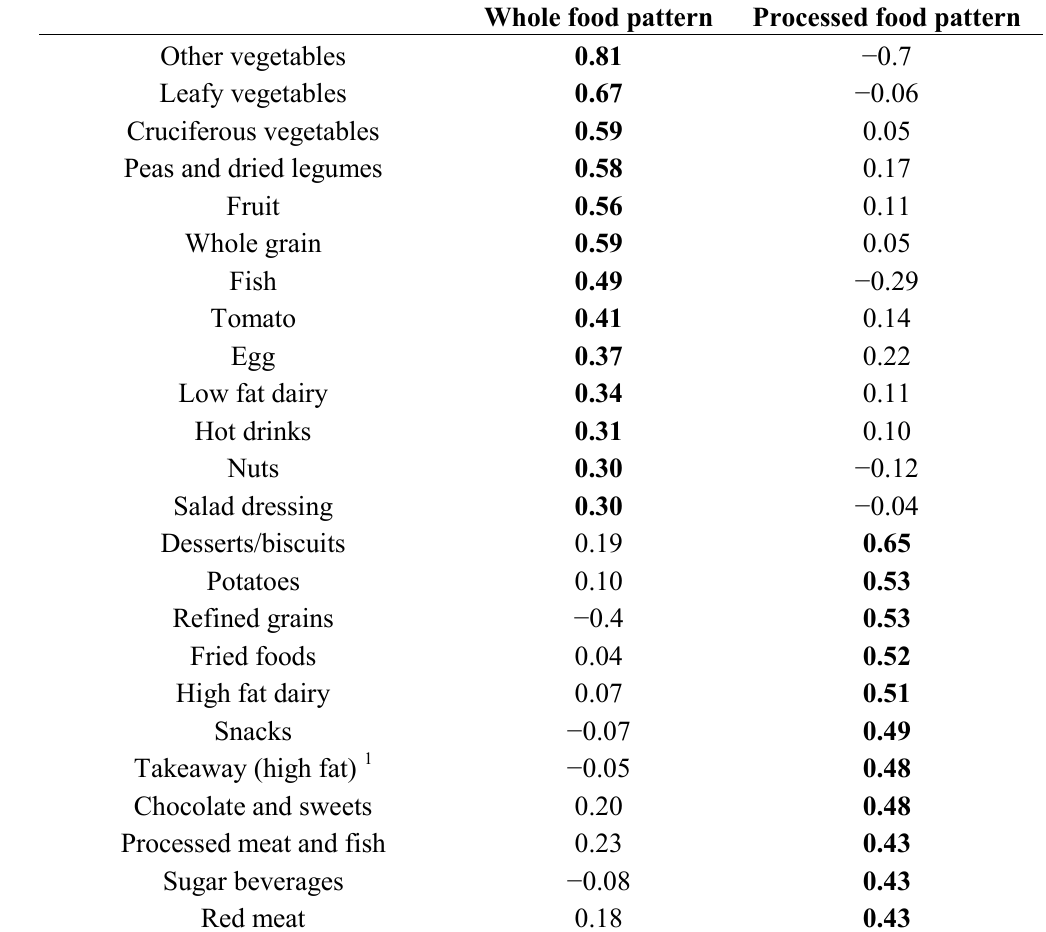
Table 1. Factor loadings for the two dietary patterns. Whole food pattern Processed food